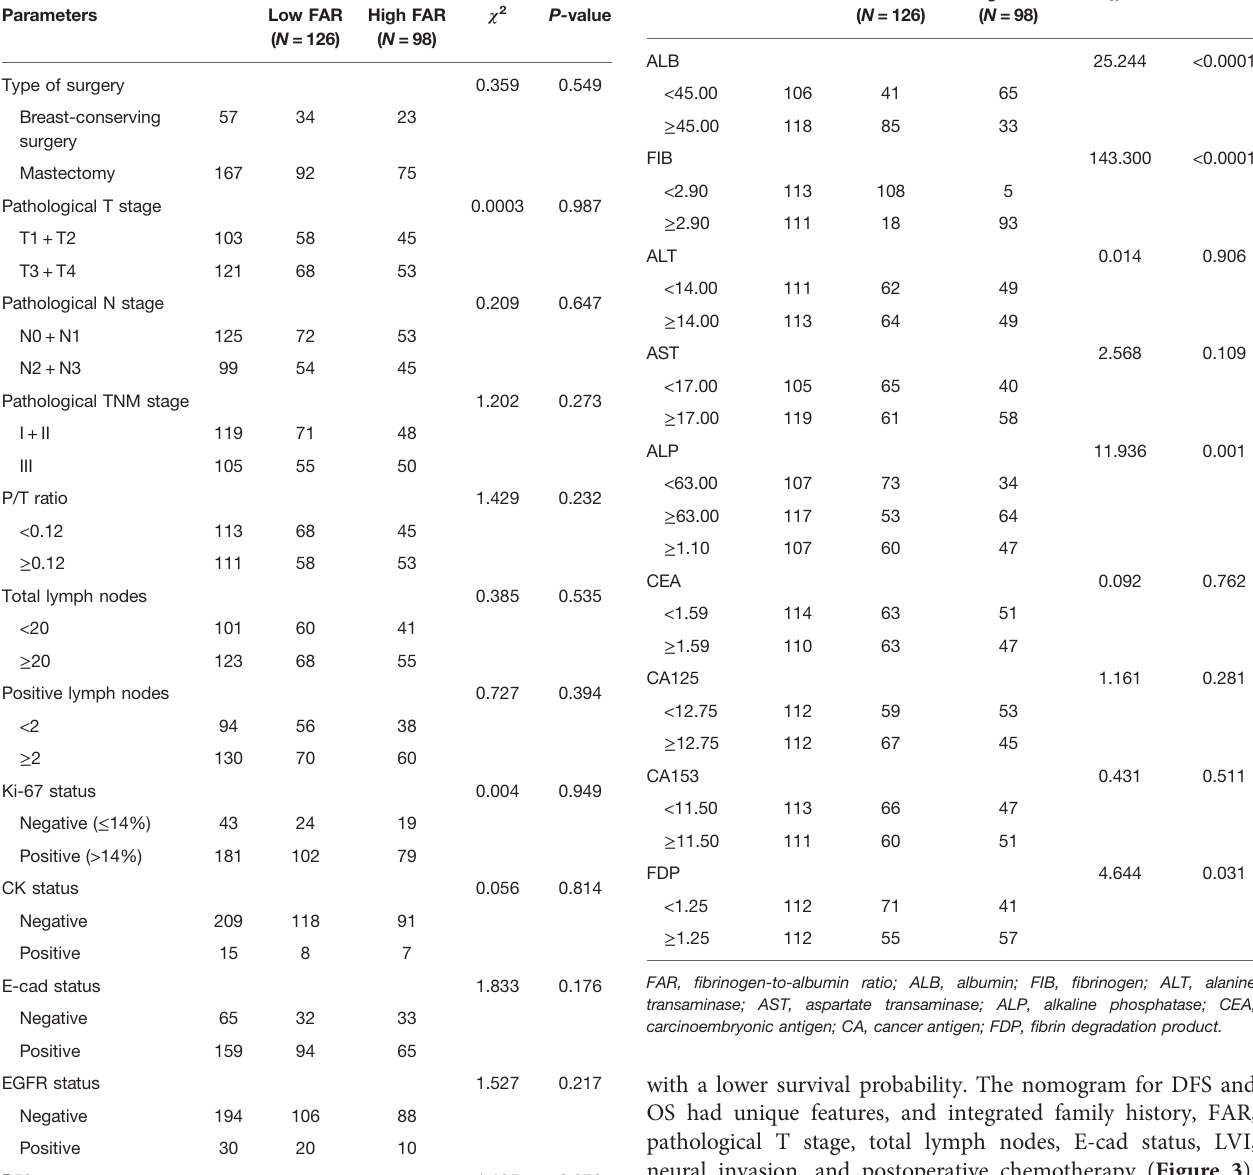
negative breast